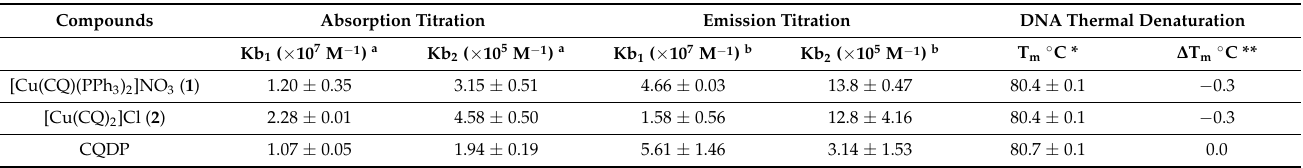
Figure 3. Spectrophotometric titration spectra of ( A ) [Cu(CQ)(PPh 3 ) 2 ]NO 3 and ( B ) [Cu(CQ) 2 ]Cl with CT-DNA. Table 1. Binding constants for the interaction between copper complexes and calf thymus DNA, and DNA thermal denaturation